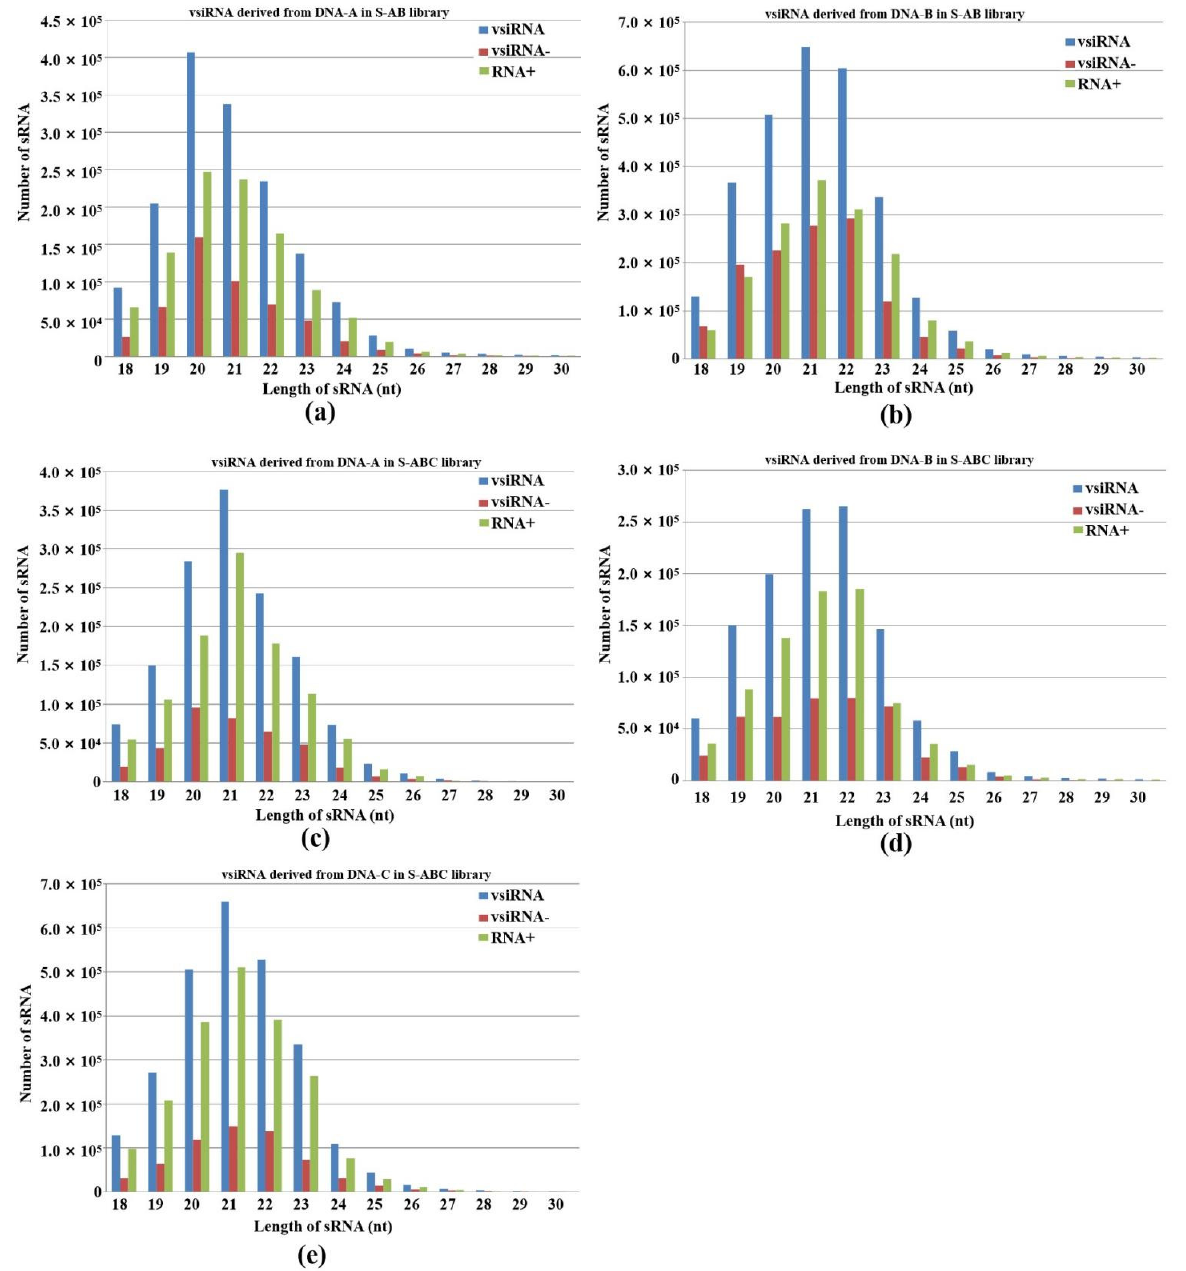
Figure 2. Abundance and size distribution of vsiRNAs along the different genome segments of FgGMTV1. vsiRNAs originating from the positive strand (vsiRNA+) and the negative strand (vsiRNA-) of ( a ) DNA-A of S-AB, ( b ) DNA-B of S-AB, ( c ) DNA-A of S-ABC, ( d ) DNA-B of S-ABC, ( e ) DNA-C of S-ABC were clustered based on size, ranging from 18 to 30 nt. The y -axis indicates the numbers of sRNAs and the x -axis represents the length distribution. Total vsiRNA is represented by blue bars, vsiRNA- by red bars, and vsiRNA+ by green bars. S-S (virus-free strain), S-AB (S-S strain infected with DNA-A and DNA-B segments of FgGMTV1), S-ABC (S-S strain infected with DNA-A, DNA-B and DNA-C segments of FgGMTV1).